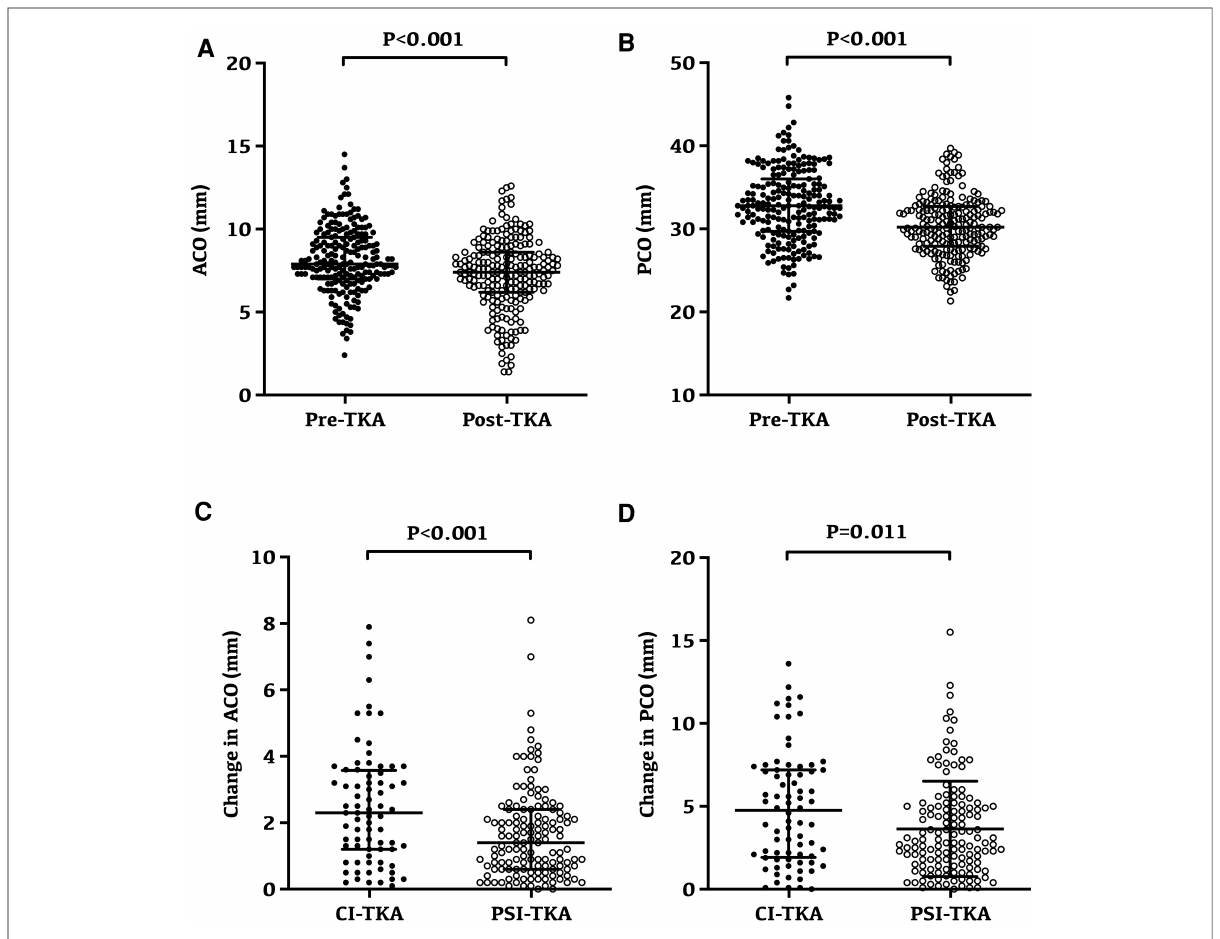
FIGURE 4 Changes and variability of anterior condylar offset and posterior condylar offset following TKA. ( A ) Preoperative and postoperative anterior condylar offset for all patients; the anterior condylar offset was 8.14±2.01 mm preoperatively and reduced to 7.29±2.21 mm after TKA ( p <0.001). ( B ) Preoperative and postoperative posterior condylar offset for all patients; the posterior condylar offset was 32.87±4.40 mm preoperatively and reduced to 30.39±3.60 mm after TKA ( p <0.001). ( C ) Anterior condylar offset after TKA had a minor change in the PSI-TKA group ( p <0.001). ( D ) Posterior condylar offset after TKA had a minor change in the PSI-TKA group ( p